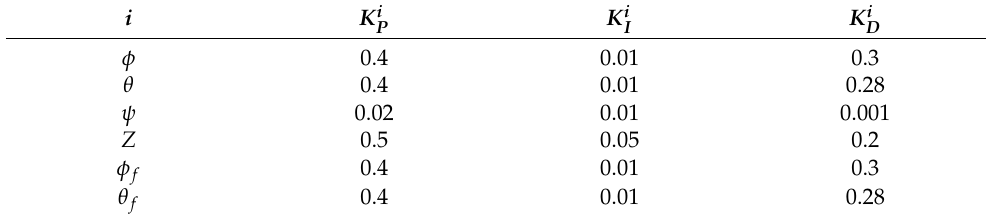
Table 1. PID parameters of the UAV